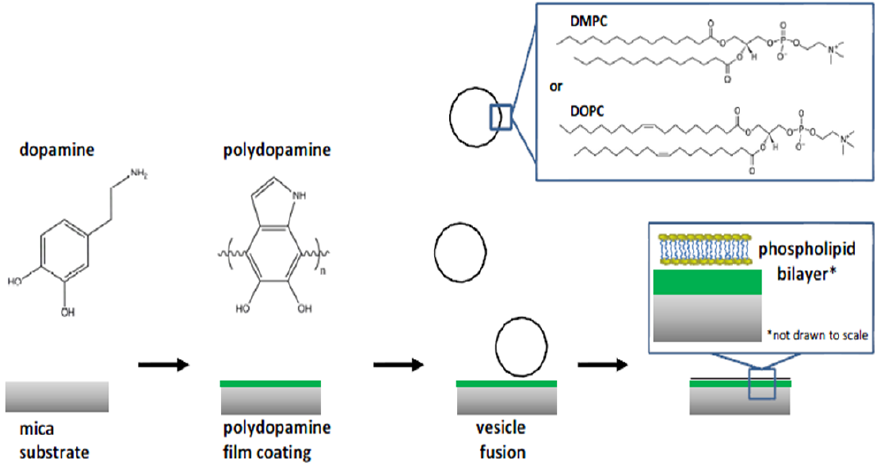
Figure 10. Preparation of polydopamine supported membranes and the structure of polydopamine. Reprinted with permission from Science [79] and Journal of Physical Chemistry C